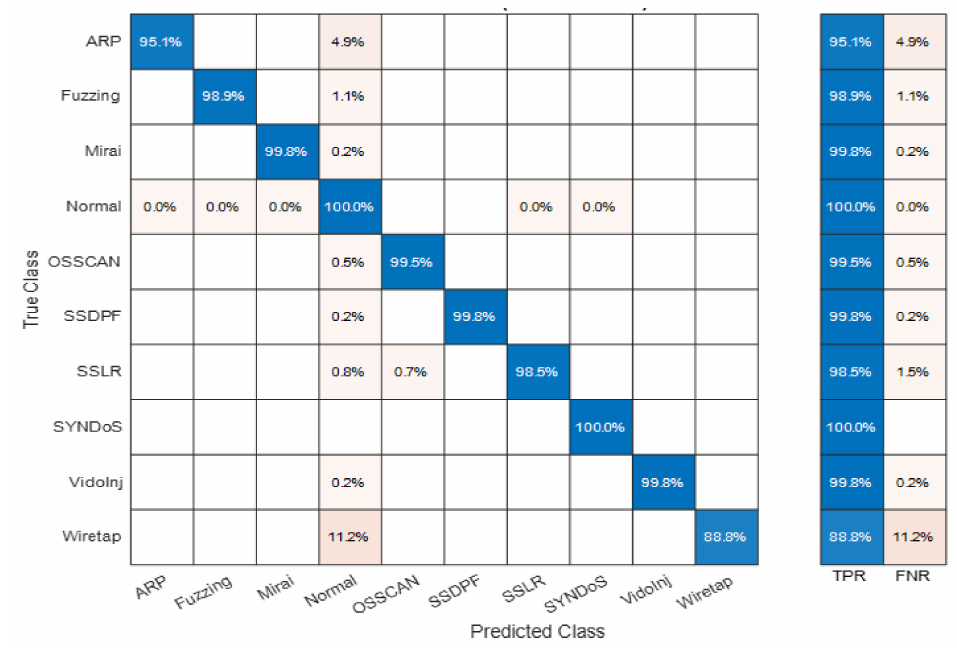
Figure 7. Matrix of TPR vs. FNR for each individual class using EBT classifier.